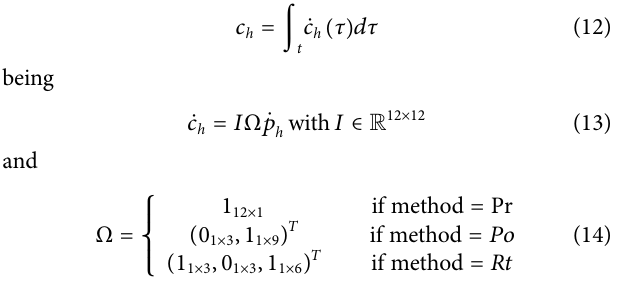
Frontiers in Robotics and AI |